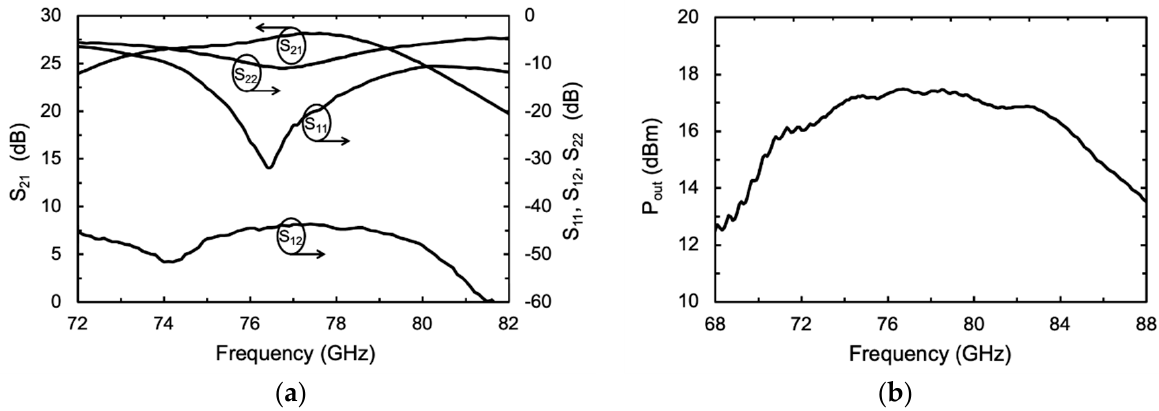
Figure 6. ( a ) Measured S-parameters of the 77 GHz PA. ( b ) Measured PA output power versus frequency.